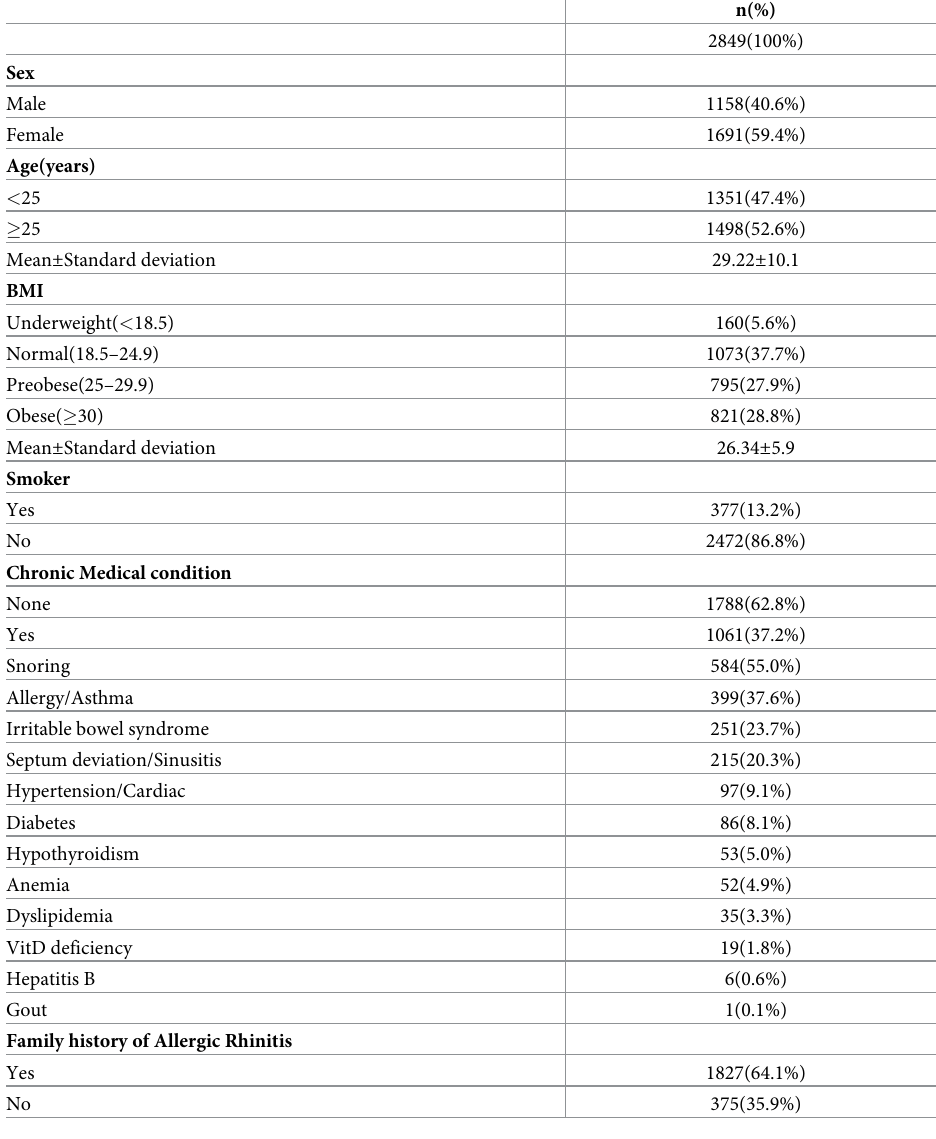
Table 1. Prevalence of allergic